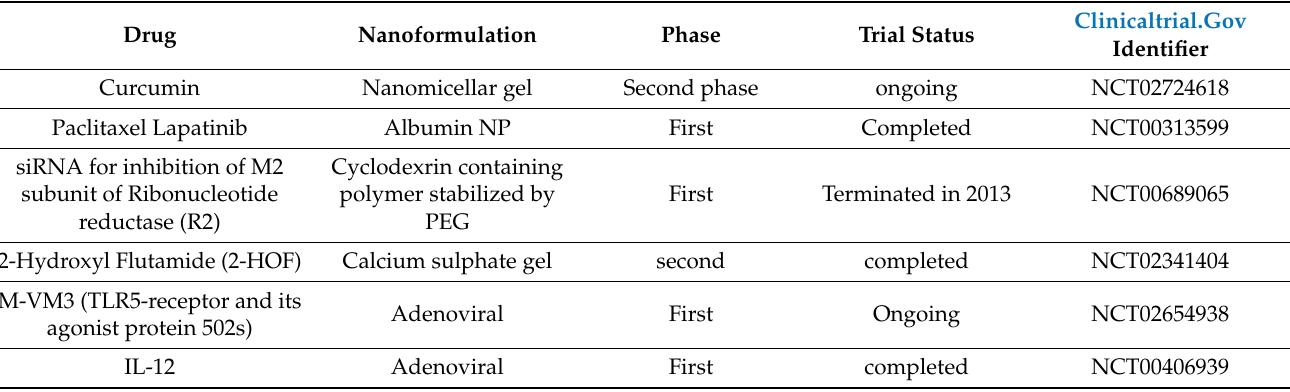
Table 4. Tabulation of the nanovectorization-based drugs in clinical trials for prostate cancer treatment, adapted from Reference [92].